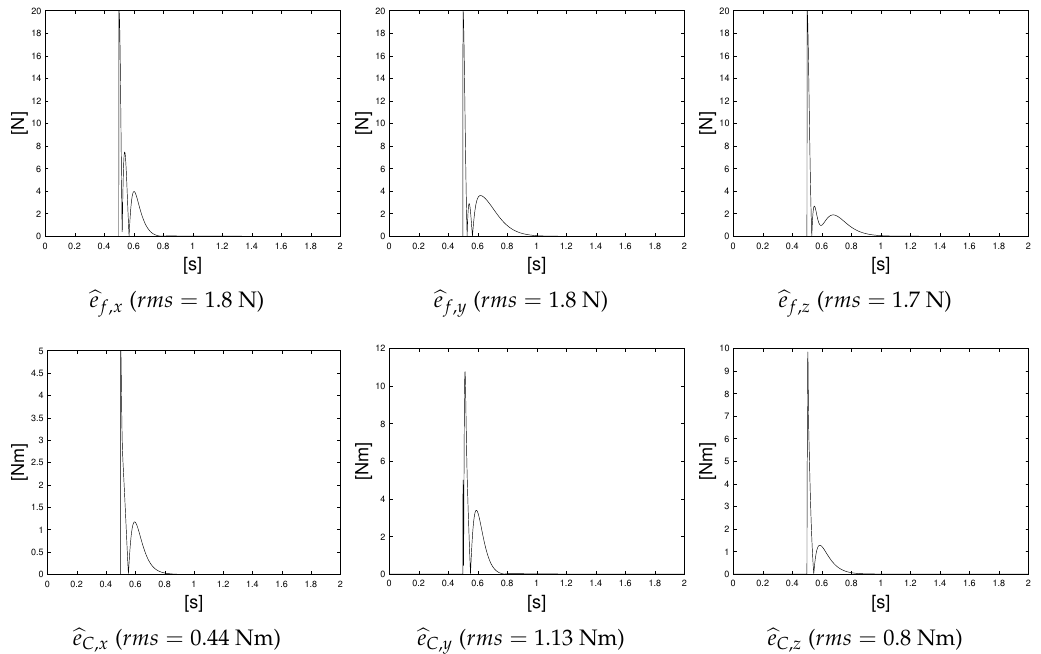
Figure 2. Estimated interaction forces (cid:98) e f and torques (cid:98) e C errors for the #1 simulation